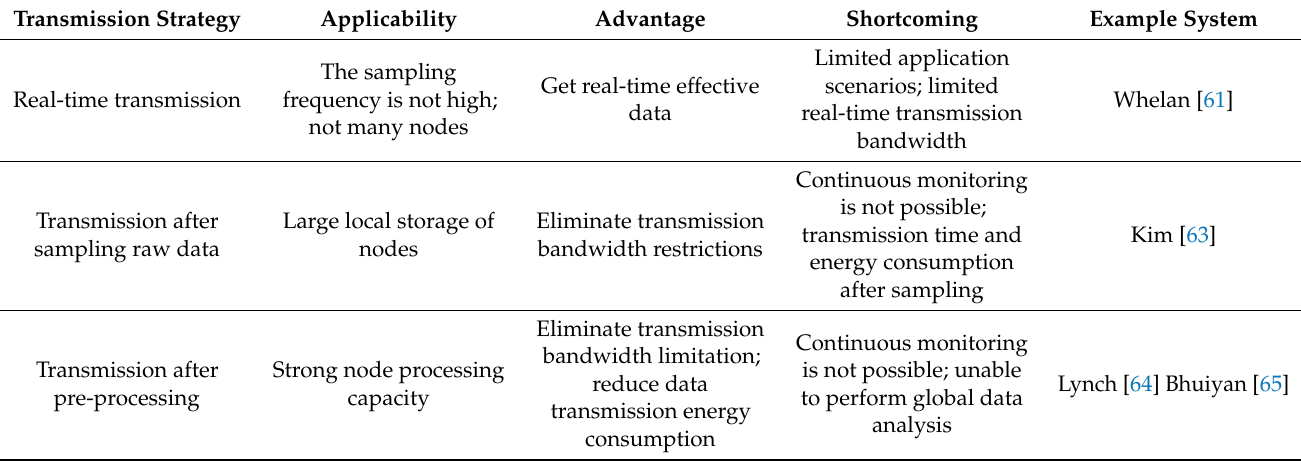
Table 1. Comparison of storage and transmission